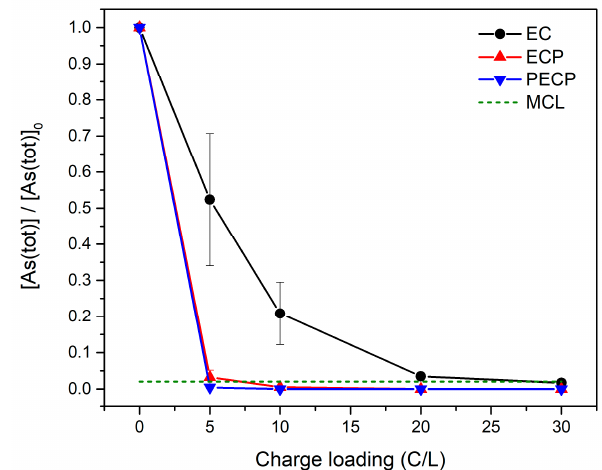
Figure 1. Removal of total arsenic from aqueous solutions containing ~500 µ g / L of As(III) at pH 7 by di ff erent physical separation electrochemically driven processes at 1 C / L / min: ( • ) electrocoagulation, ( (cid:78) ) electrochemical peroxidation, ( (cid:72) ) photo-assisted electrochemical peroxidation. Dashed line indicates the maximum contaminant level of 10 µ g / L recommended by the World Health Organization.